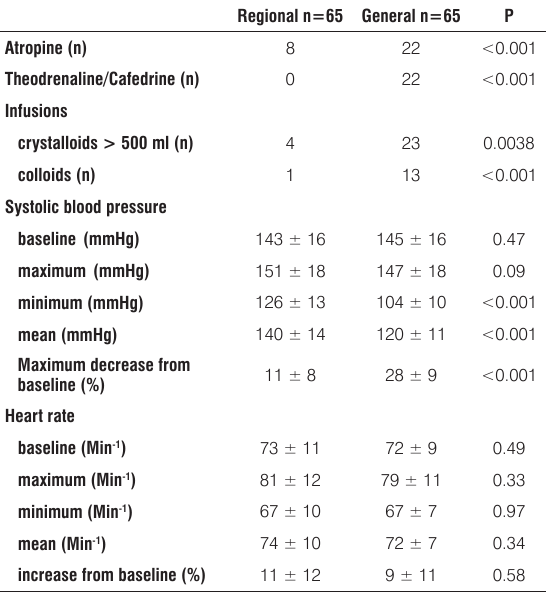
Table 3. Hemodynamic parameters and circulatory support drugs.